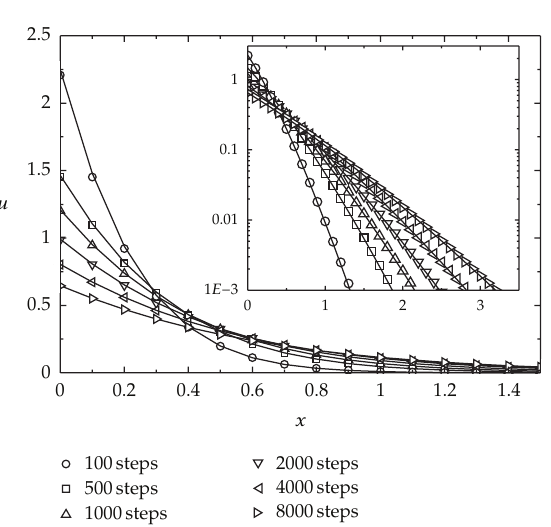
Figure 5: Exact solution (cid:5) lines (cid:6) and numerical solution (cid:5) symbols (cid:6) provided by our method for the fractional cable equation with γ 1 (cid:7) 0 . 5 and γ 2 (cid:7) 0 . 5 for di ff erent numbers of timesteps when Δ x (cid:7) 1 / 10, Δ t (cid:7) 10 − 5 , K (cid:7) μ (cid:7) 1, L (cid:7) 5, and S (cid:7) (cid:5)Δ t (cid:6) γ 1 / (cid:5)Δ x (cid:6) 2 (cid:7) 0 . 316. This case is inside the stability region because S is smaller than the stability limit S × (cid:7) (cid:5) 2 γ 2 − μ 2 (cid:5)Δ t (cid:6) γ 2 (cid:6) / (cid:5) 2 2 (cid:9) γ 2 − γ 1 (cid:6) (cid:3) 0 . 352 ... provided by (cid:5) 3.7 (cid:6) . The inset shows the results on logarithmic scale.